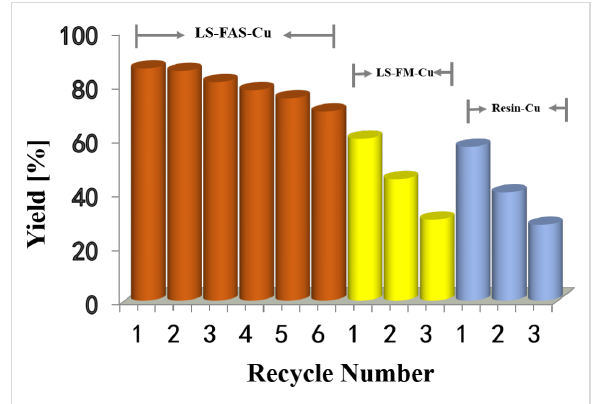
Figure 6: Recyclability of LS-FAS-Cu, LS-FM-Cu and Resin-Cu in the reaction between compounds 1a , 2a and 3a